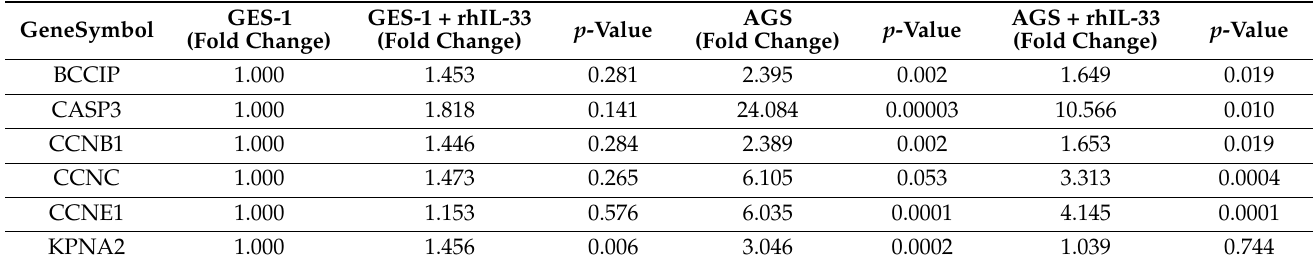
Figure 5. Cell cycle evaluation by staining of cells with propidium iodine after exogenous rhIL-33 treatment and cytofluorimetric cell count showed in ( a ) GES-1 an increase in the percentage of cells in phase S at the expense of the other two, perhaps for a block between S phase and G2 phase, while in ( b ) AGS, IL-33 increased the percentage of cells in phases G1/G0 and S, and the latter decreased considerably after 24 h treatment. Data are shown as the mean of % of gated cells. * p < 0.05; ** p < 0.01; *** p < 0.001. Table 2. Cell cycle genes differentially regulated in GES-1 and AGS cells after rhIL-33 stimulation. Using GES-1 as control cell line, we selected a subset of genes that were differentially regulated between the two cell lines.